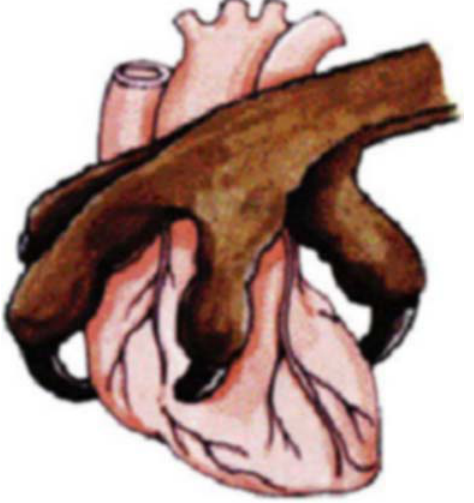
Figure 2. His heart was gripped by a bird’s